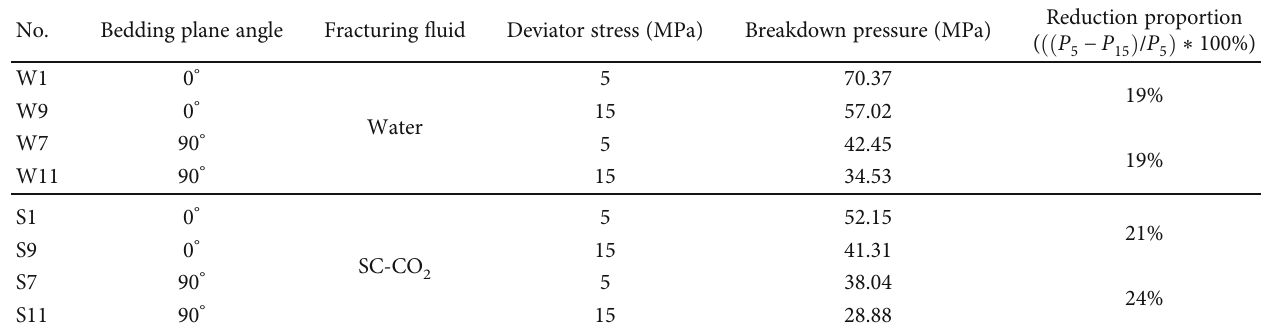
Table 4: Reduction proportion of shale breakdown pressure under di ff erent deviator stresses.